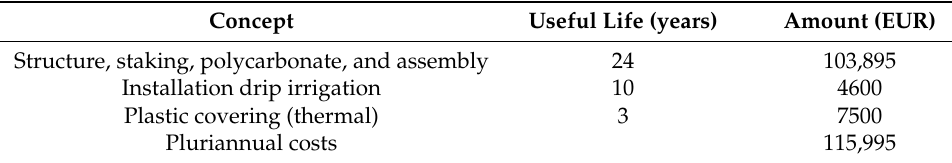
Table 9. Pluriannual costs.